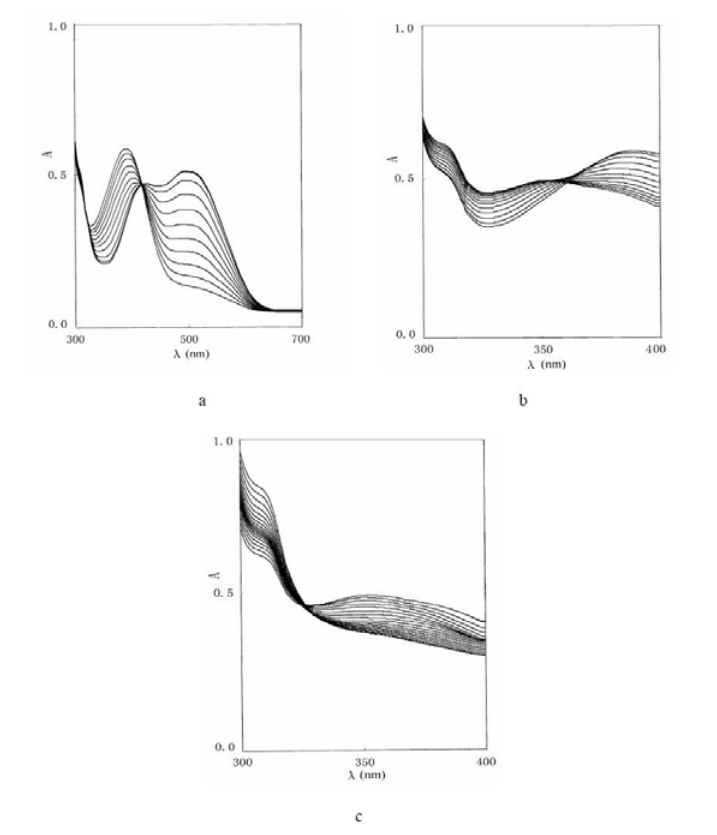
Fig. 8 Kinetic spectra of the LiP catalyzed oxidation of PR at different stage of the reaction. Conditions: [PR] = 40 μ M; [LiP] = 0.1 μ M; [GOD] = 0.3 μ g · mL − 1 ; [glucose] = 0.1 mM; [VA] = 10 mM; the time interval for scanning at the first (a), second (b) and third (c) stages of the reaction was 2.5 min (a), 1.5 min (b), and 5.0min(c),